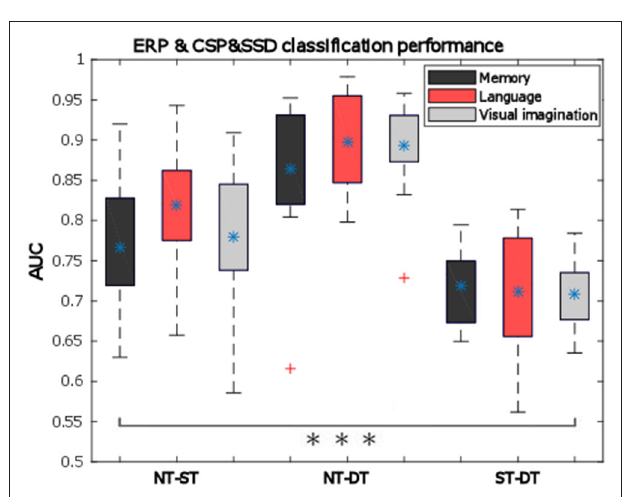
of classification based on ERP only were presented in Nicolae et al. (2015b).